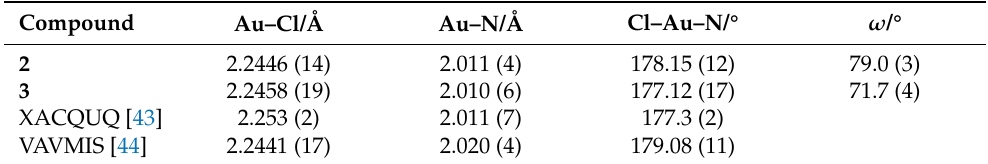
Table 1. Comparison of the coordination environment about the Au I in 2 , 3 and two selected literature structures.